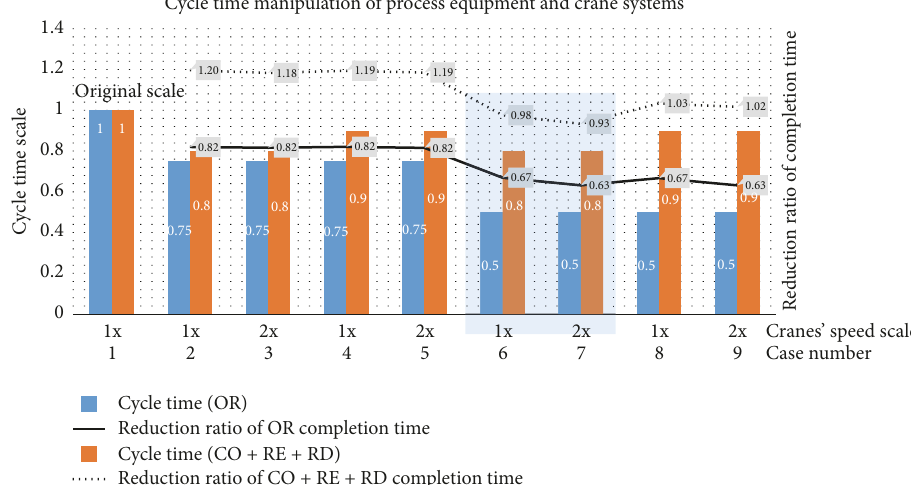
Figure 10: Simulation results for cycle time changes of the OR station and the CO, RE, and RD stations in the original layout using